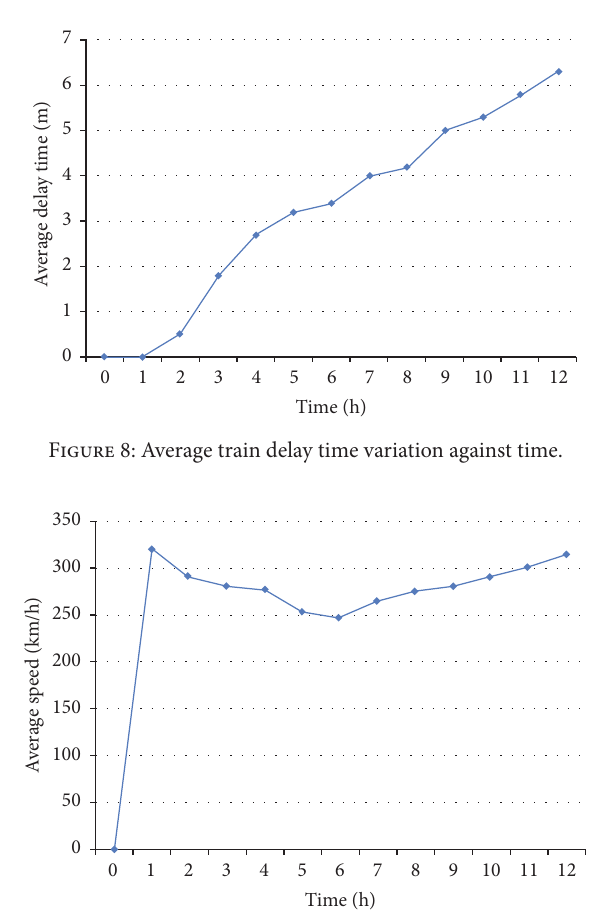
Figure 11: Average train delay time variation against